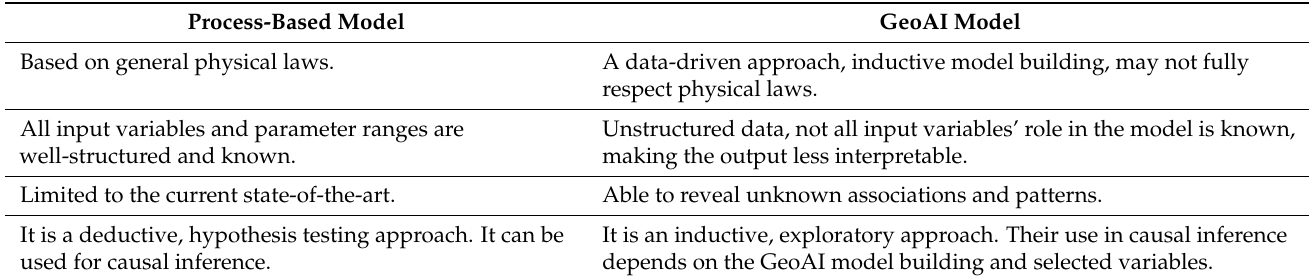
Table 6. Characteristics of physical-based and GeoAI hydrological